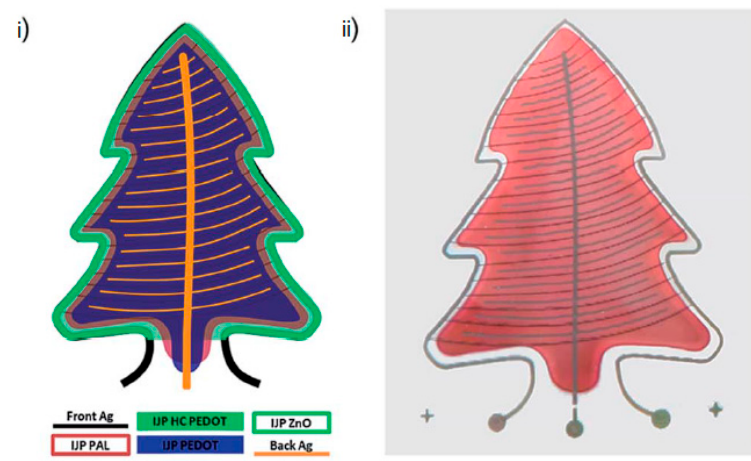
Figure 2. A flexible organic solar cell in the form of a Christmas tree, ( i ) layout diagram of printed layers; ( ii ) A snapshot of completely inkjet-printed organic photovoltaic (OPV) Christmas tree [22].